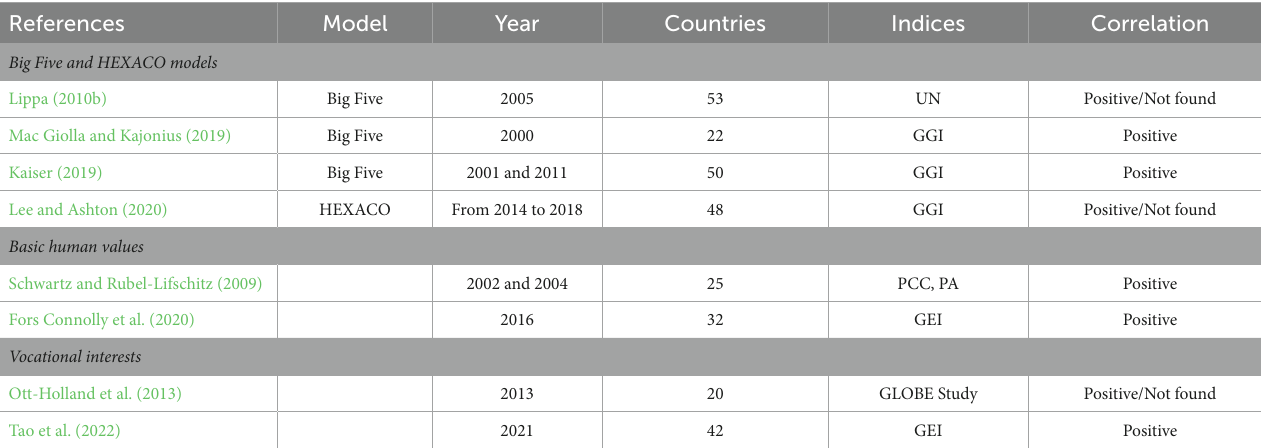
TABLE 3 Correlations between gender differences in personality (men–women) and composite indices of gender